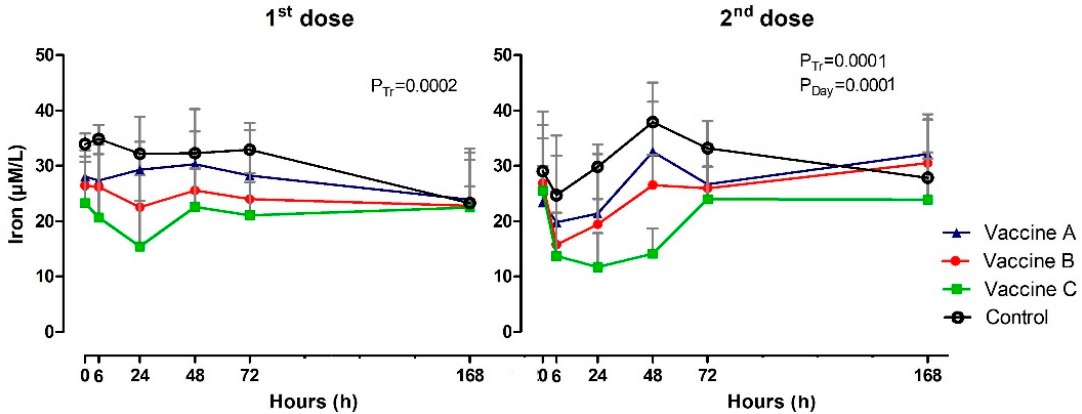
Figure 5. Clinical pathology by serum iron levels (µM/L) in animals vaccinated with three different formulation adjuvanted vaccines against BVDV and BHV-1. Reported are the mean values and standard deviations. Overall statistical significance ( p ≤ 0.05) is indicated in the plot as follows: Effects of treatment (P tr ), day (P Day ) and interactions (P tr x P Day ).